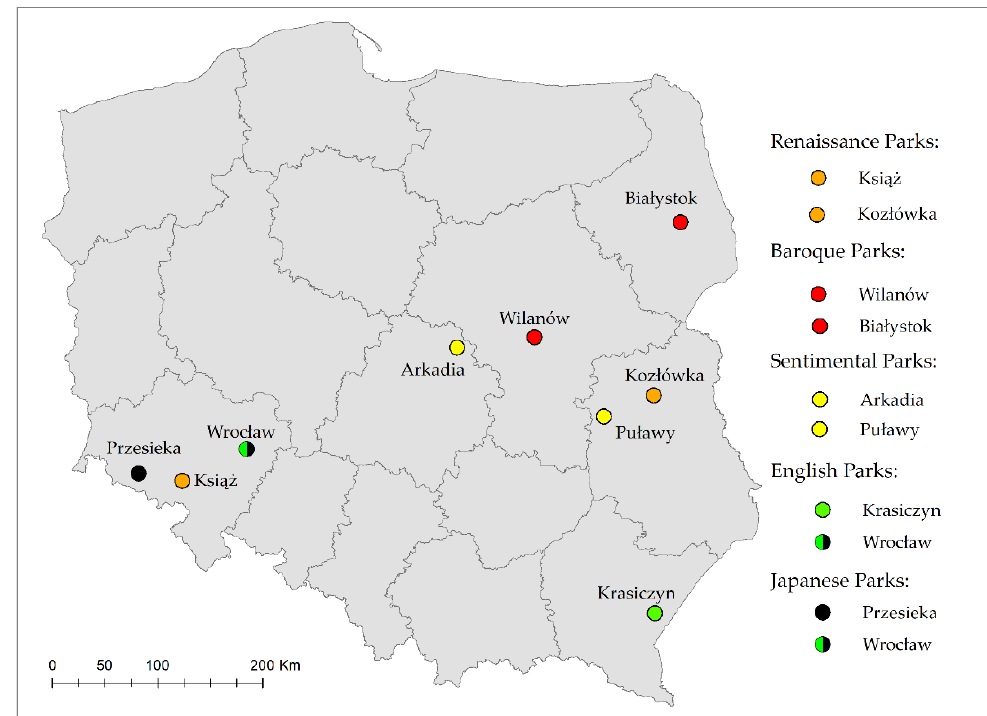
Figure 2. Location of garden parks in 5 styles: Renaissance, Baroque, Romantic/Sentimental, Land- scape/English, and Oriental/Japanese.